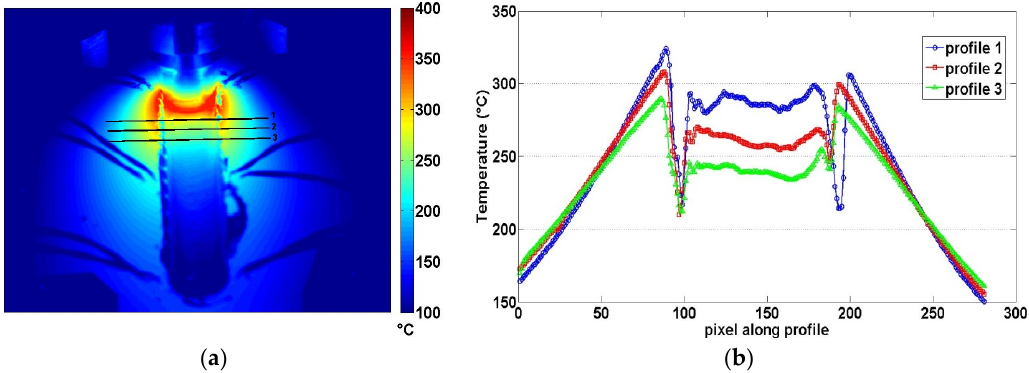
Figure 11. ( a ) Image obtained at the end of the welding; ( b ) Three thermal profiles acquired during Test 1 in a fixed time instant.